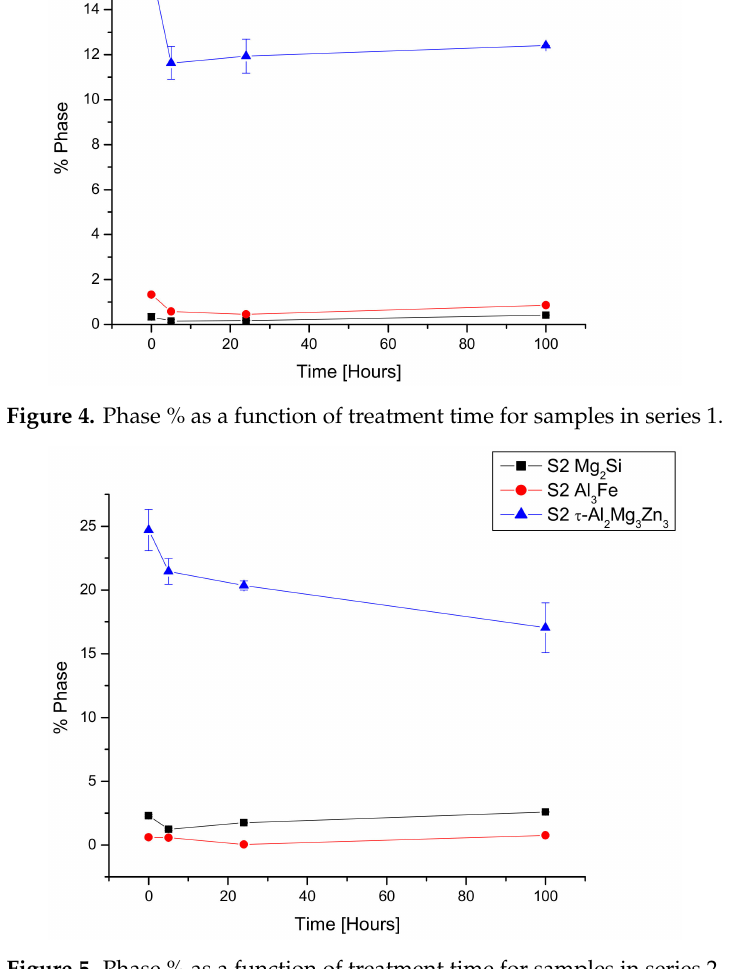
Figure 5. Phase % as a function of treatment time for samples in series